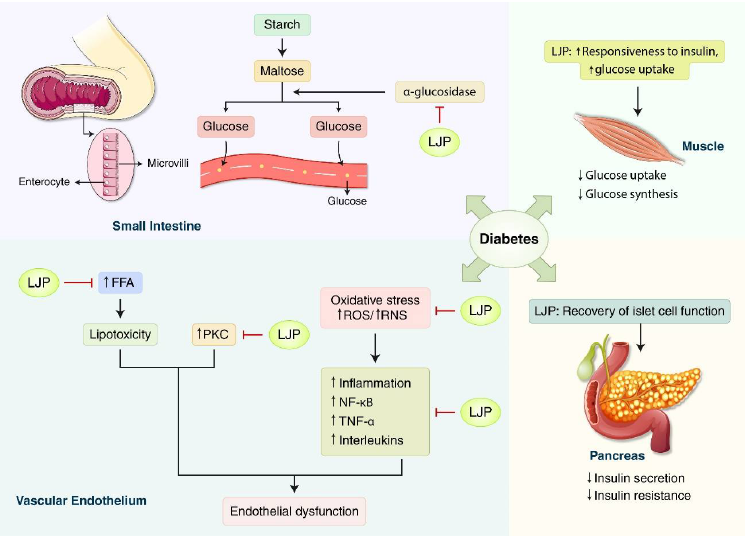
Figure 2. Schematic overview of main mechanisms of Laminaria japonica (LJP) against diabetes. Insulin resistance with impairment of insulin signaling, hyperinsulinemia, and hyperglycemia con- tributes to multiple processes including elevated free fatty acids (FFA), protein kinase C (PKC) ac- tivation, and oxidative stress, contributing to inflammation and endothelial dysfunction simultane- ously. LJP may decrease the mobilization of FFA and oxidative stress, the downregulation of PKC, and the modulation of inflammatory mediators including tumor necrosis factor-α (TNF-α) and in- terleukins, and the nuclear factor kappa B (NF-κB) signaling pathway. Meanwhile, α-glucosidases are glycoside hydrolases found on the luminal surface of enterocytes containing maltase activities. LJP can help regulate and maintain an adequate blood sugar level by inhibiting α-glucosidase. LJP also has the potential to increase glucose uptake and responsiveness to insulin in the muscle and recover the pancreatic islet cell secreting function. FFA: free fatty acids; LJP: Laminaria japonica ; NF- κB: nuclear factor kappa B; PKC: protein kinase C; TNF-α: tumor necrosis factor-α; ↑ : increased; ↓ : decreased.